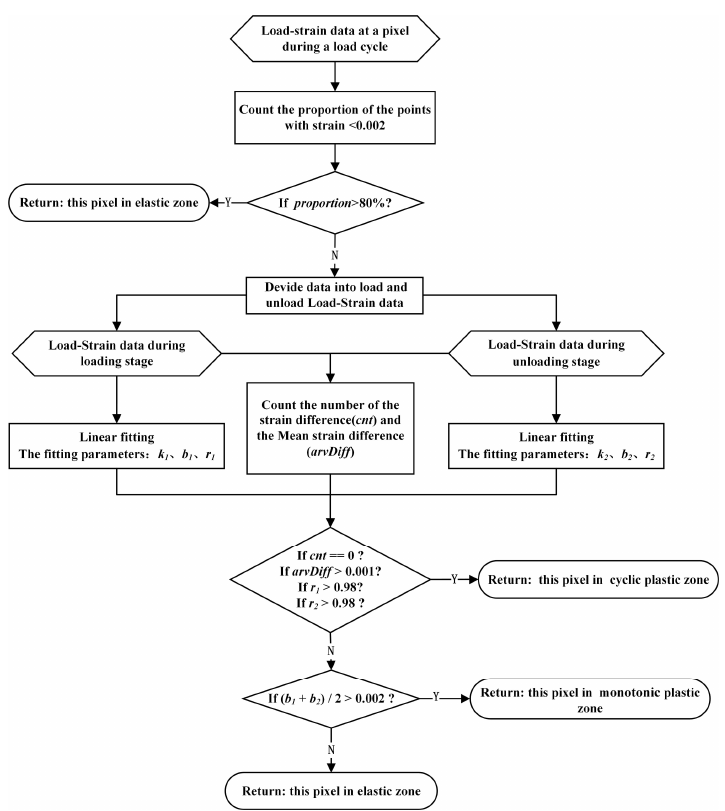
Figure 12. Load–strain loop curve characteristic judging process.